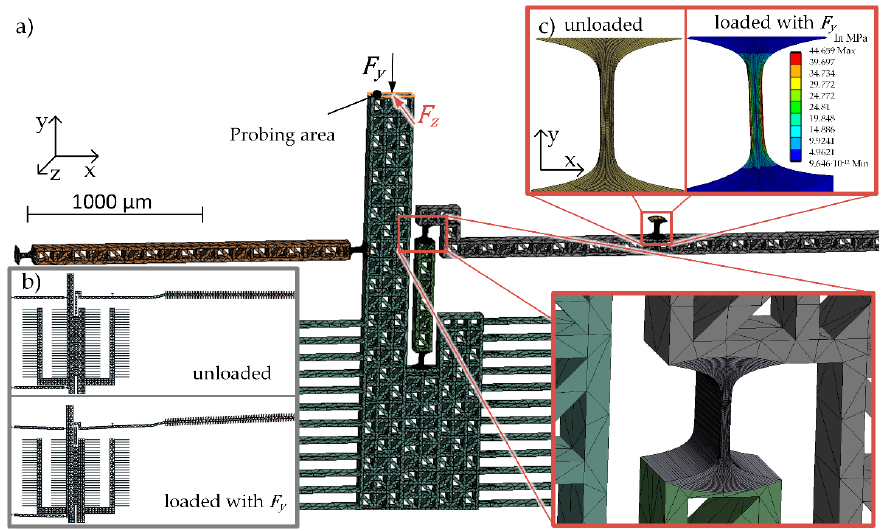
Figure 4. ( a ) Illustration of sections of the meshed FEM model (software ANSYS); ( b ) weighing cell in an unloaded and a loaded state with the force 𝐹 (cid:3052) ; ( c ) FEM simulation of an unloaded hinge G and the principal stress distribution if the hinge is loaded with a force 𝐹 (cid:3052)